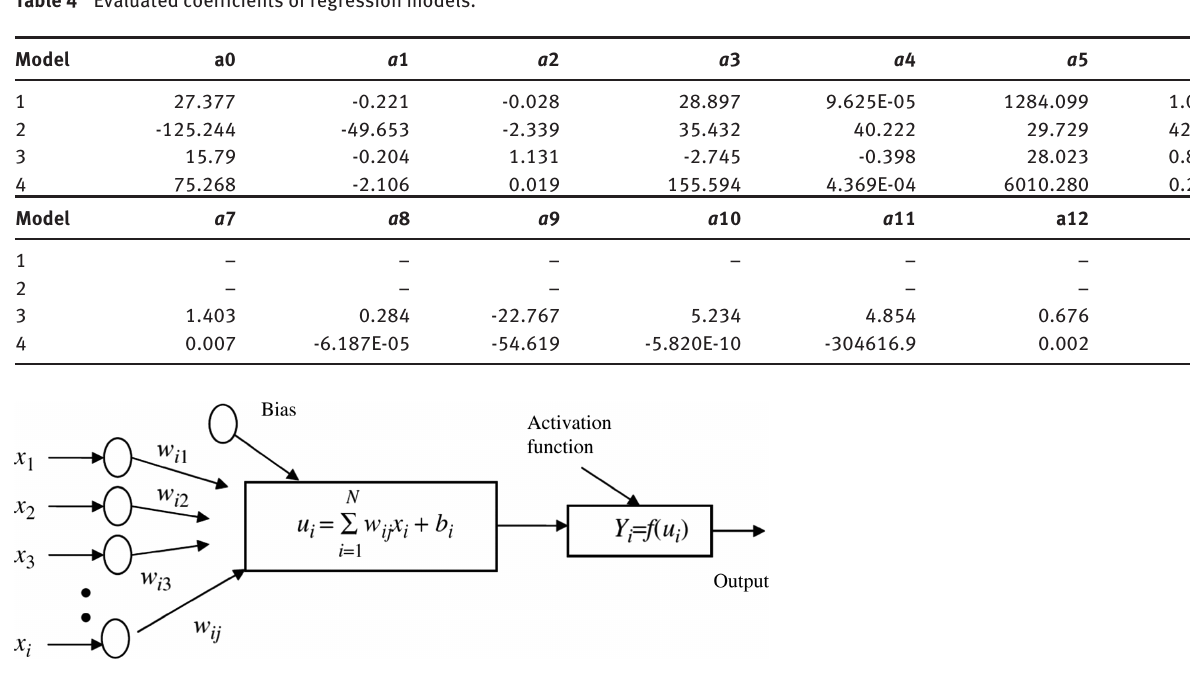
Figure 2 Basic elements of an artificial neuron.